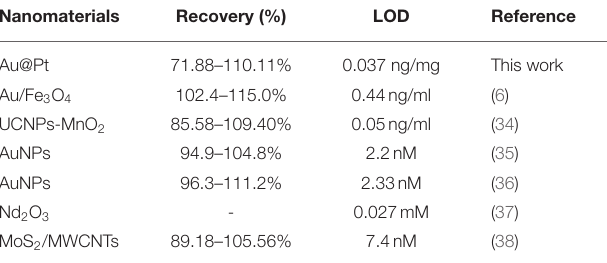
TABLE 2 | Various assays for detection of CBZ based on